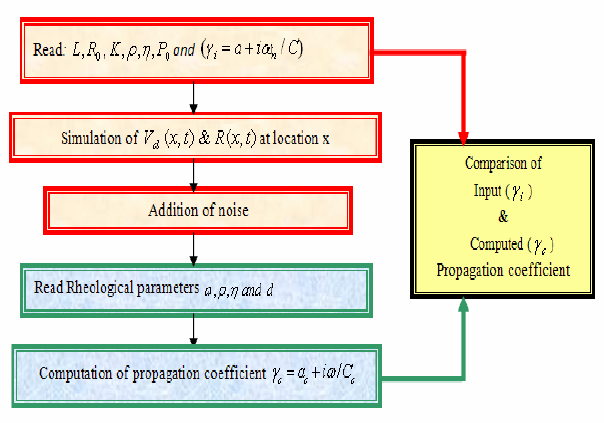
Fig.1 Simplified representation of the numerical procedure.